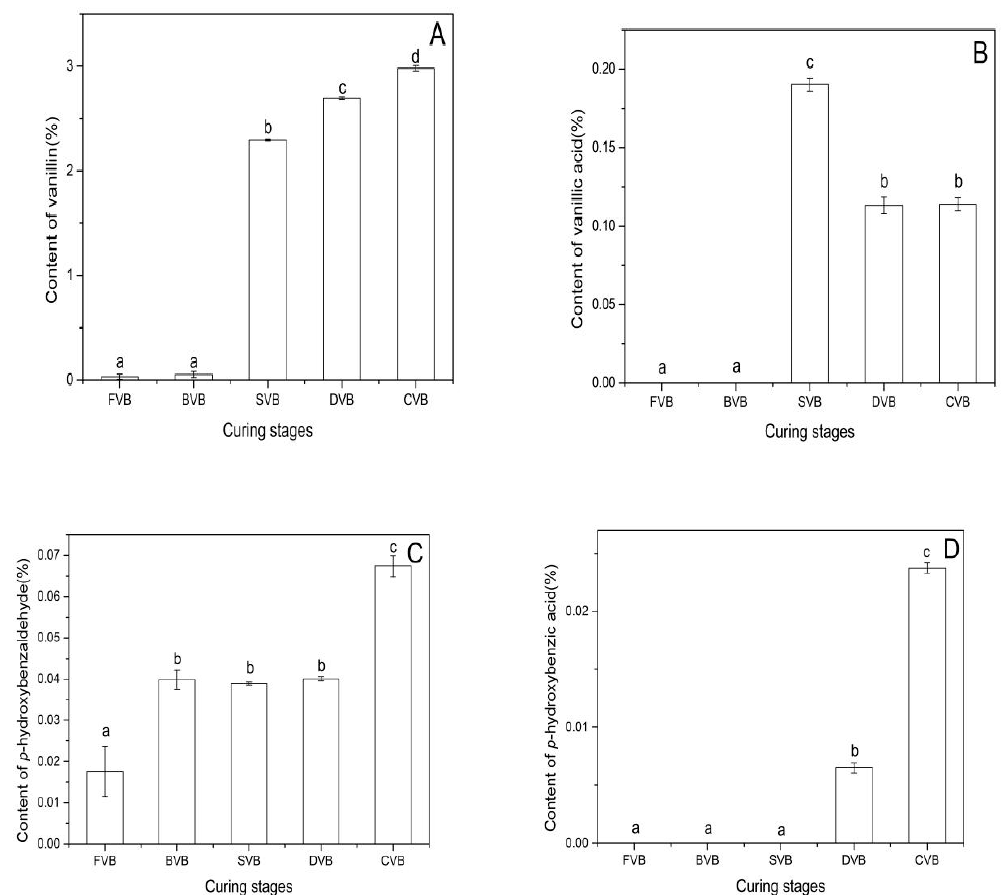
Figure 3. Amounts (% dw) of the main vanilla flavors in vanilla beans of the different curing stages: ( A ) Vanillin, ( B ) vanillic acid, ( C ) p -hydroxybenzaldehyde and ( D ) p -hydroxybenzoic acid. Bars represent the standard deviation of the three replicates. Data were subjected to Duncan’s test ( p < 0.05). Different letters indicate quantities that are either statistically significantly different between different stages (a,b,c,d). FVB: Fresh vanilla bean; BVB: Blanched vanilla bean; SVB: Sweating vanilla bean; DVB: Drying vanilla bean; CVB: Cured vanilla bean.